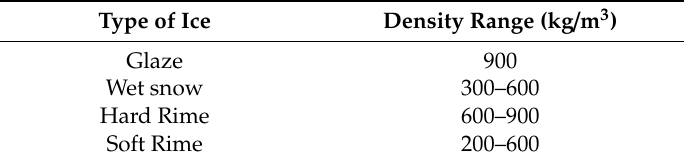
Figure 18. Ice accretion of all studied materials obtained under glaze ice conditions. Table 5. Density of ice types, after ISO 12494:2017